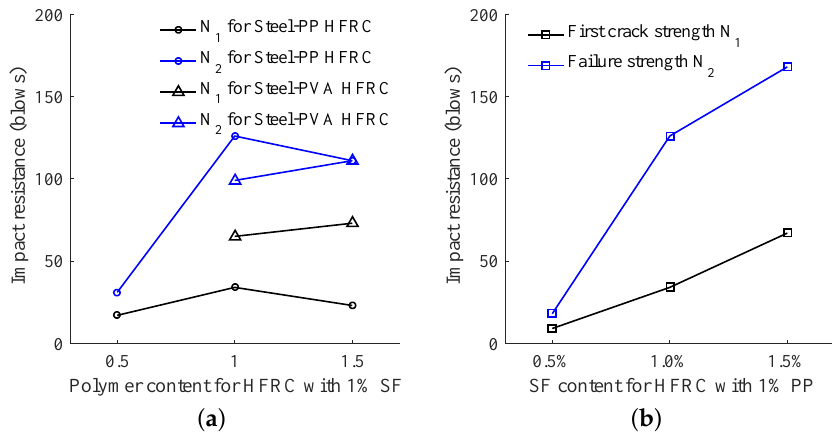
Figure 11. Fiber content effect on drop impact energy. ( a ) HFRC with 1% SF content; ( b ) Steel-PP HFRC with 1% PP